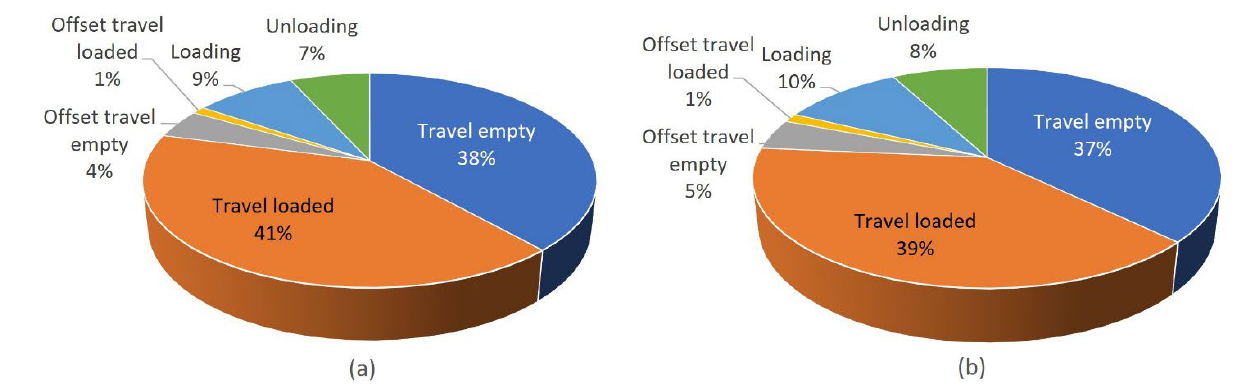
Figure 6. The structure of the forklifts’ energy consumption in performing inbound docking opera- tions, with empirical and with optimal dock doors allocation.